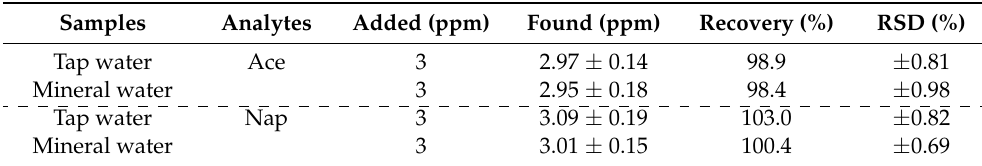
Table 2. Recovery of analytes in water